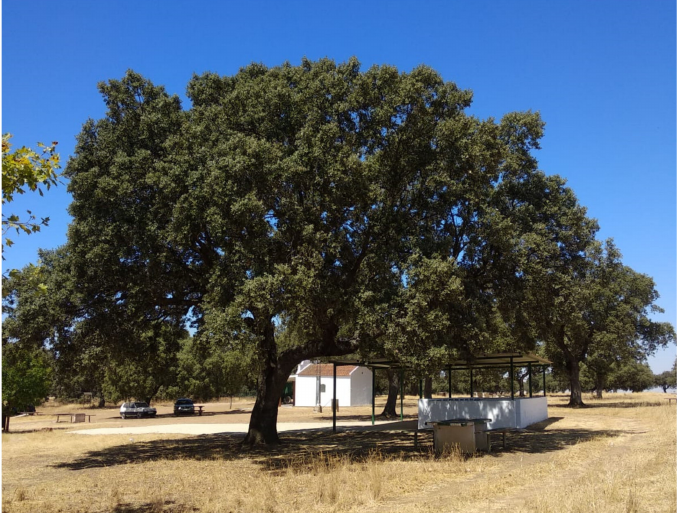
Figure 1. Tree used to obtain the first draft genome of Q. ilex , located in Aldea de Cuenca, Fuente Obejuna, Cordoba, Andalusia, Spain (38 ◦ 19 (cid:48) 46 (cid:48)(cid:48) N, 5 ◦ 33 (cid:48) 15 (cid:48)(cid:48)